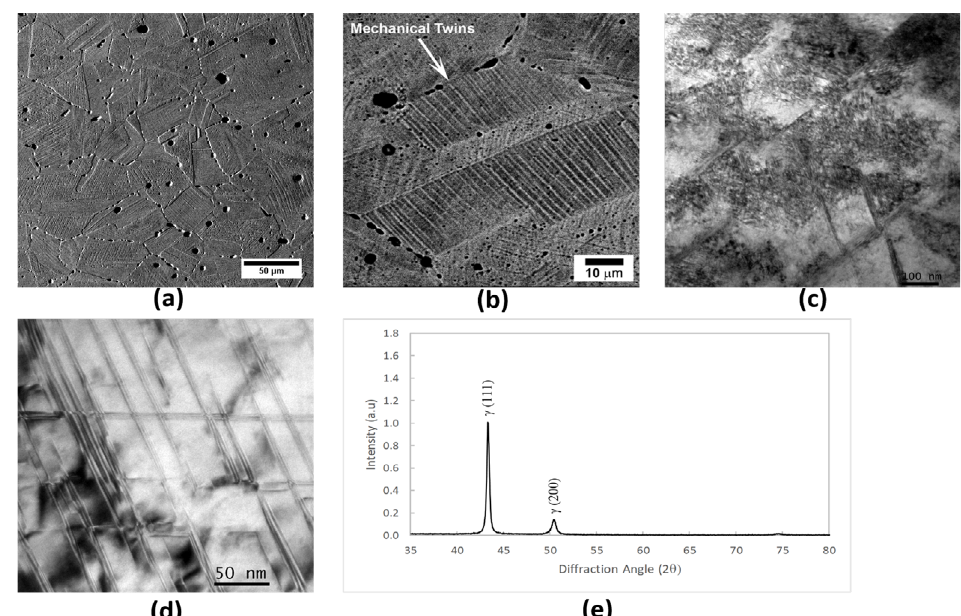
Figure 2. Micrographs of the ST + 2ECAE sample: (a) and (b) SEM-BSE; (c) and (d) TEM-BF, (e) X-Ray Diffraction Pattern.